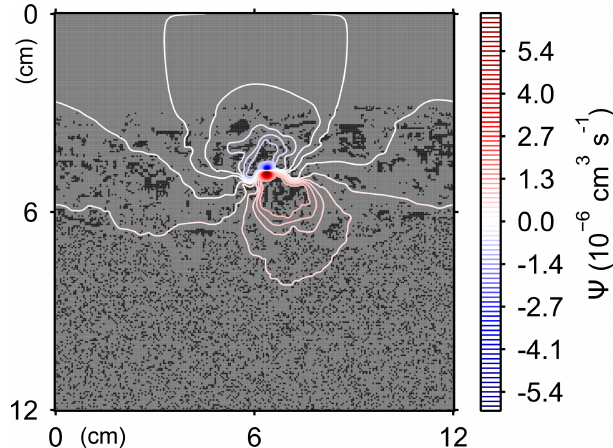
Figure 3. Stream function calculated at 225 model days from the start of a simulation in eLABS using the default settings (Sect.